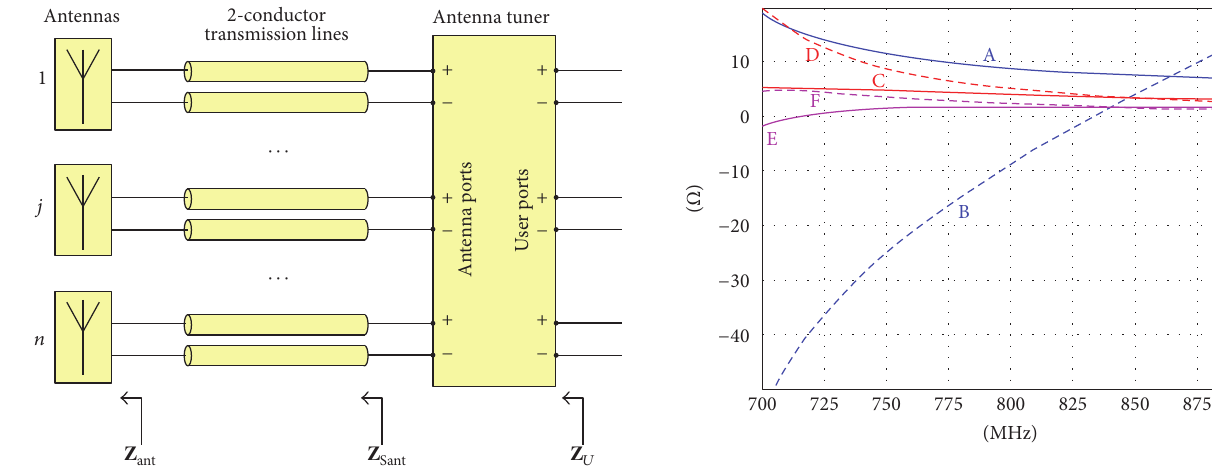
Figure 3: Entries of Z Sant versus frequency: Re ( Z Sant 11 ) is curve A; Im ( Z Sant 11 ) is curve B; Re ( Z Sant 12 ) is curve C; Im ( Z Sant 12 ) is curve D; Re ( Z Sant 13 ) is curve E; Im ( Z Sant 13 ) is curve